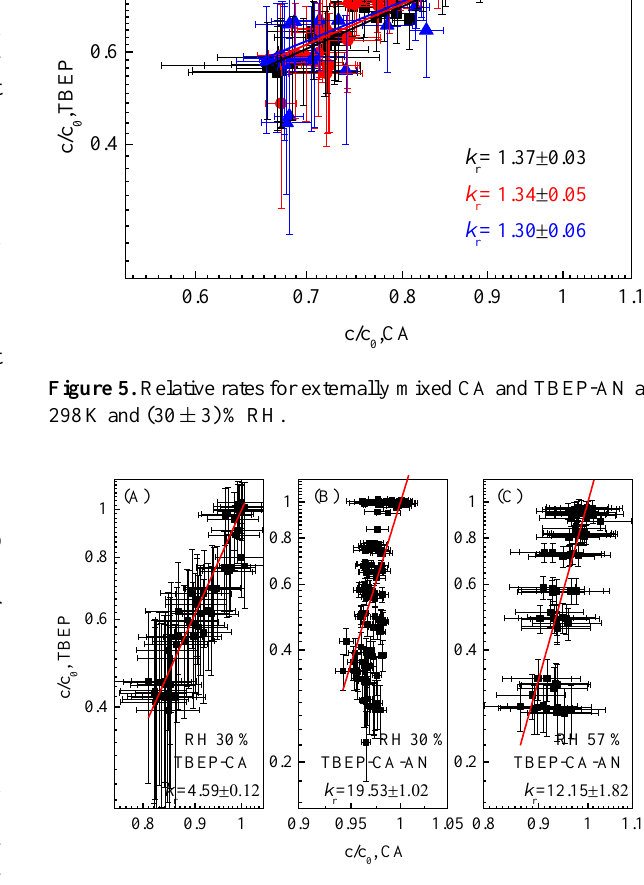
and b. In Fig. 6, the k r of TBEP to CA for internally mixed particles increases greatly when compared with the exter- nally mixed CA and TBEP-AN (Fig. 5). For internally mixed TBEP-CA particles (Fig. 6a) the k r is 4.59 ± 0.12, and in- creases to 19.53 ± 1.02 for internally mixed TBEP-CA-AN particles (Fig. 6b). The consumption of TBEP and CA rel- ative to their corresponding initial concentrations from high to low OH exposure is shown in Fig. 7 for externally mixed CA and TBEP-AN (Fig. 7a), internally mixed TBEP-CA and TBEP-CA-AN (Fig. 7b, c) at 298 K and (30 ± 3) % RH. The oxidation of CA is significantly depressed in the internally mixed experiments (b, c), while TBEP oxidation is slightly